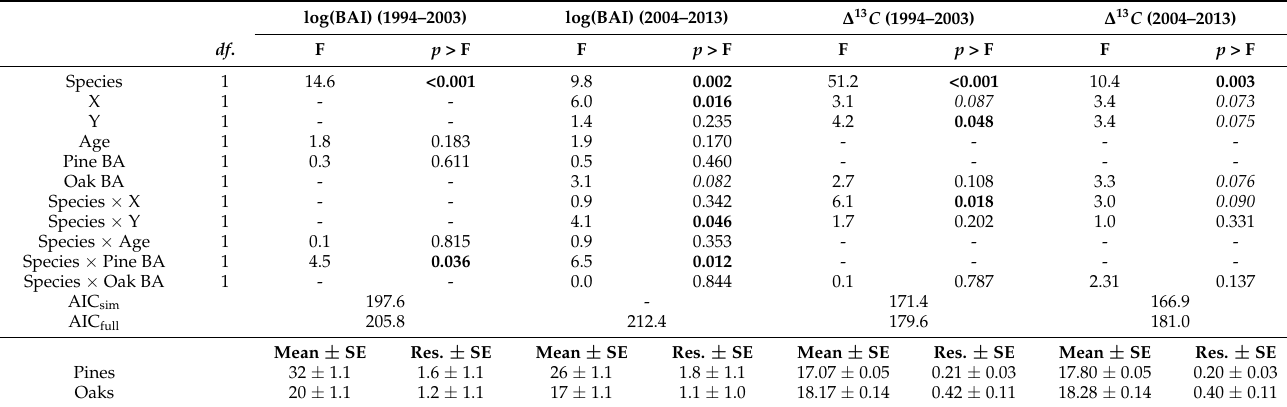
Figure 3. Boxplot for ( A ) individual basal area increment (BAI) and ( B ) carbon isotope discrimination ( ∆ 13 C ) of oaks and pines during a wet (1994–2003, green boxes) and a dry decade (2004–2013, orange boxes). Boxes stand for the 25% (Q1), 50% (median) and 75% (Q3) percentiles, and whiskers indicate the highest and lowest value within ± 1.5 fold of the inter-quantile range (Q3–Q1). Outliers beyond these limits are shown as individual dots. Table 3. Analyses of covariance (ANCOVAs, simplified model) for log-transformed individual basal area increment (log(BAI)) and carbon isotope discrimination ( Δ 13 C ) during a wet (1994–2003) and a dry decade (2004-2013). Pine and oak BA, local density of pines and oaks, respectively; Res., residual variance; X and Y, Easting and Northing coordinates, respectively. AIC, Akaike Information Criterion for the full (AIC full ) and simplified models (AIC sim ) is also shown. Factors with p < 0.05 and p < 0.10 are highlighted in bold and italics, respectively.